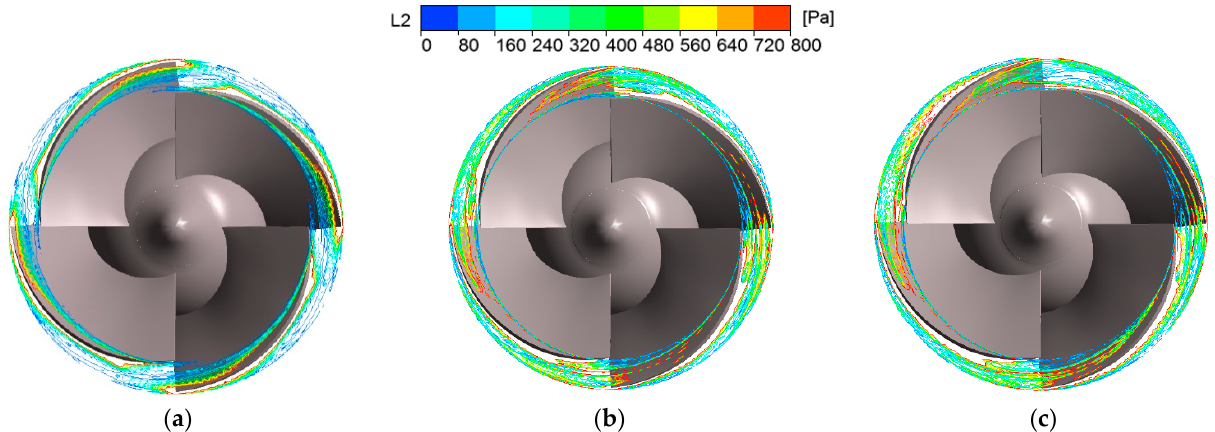
Figure 15. L 2 distribution of runner end wall area with uneven tip clearance (span = 0.99). ( a ) e = 0 mm, ( b ) e = 3 × 10 − 1 mm, ( c ) e = 5 × 10 − 1 mm.